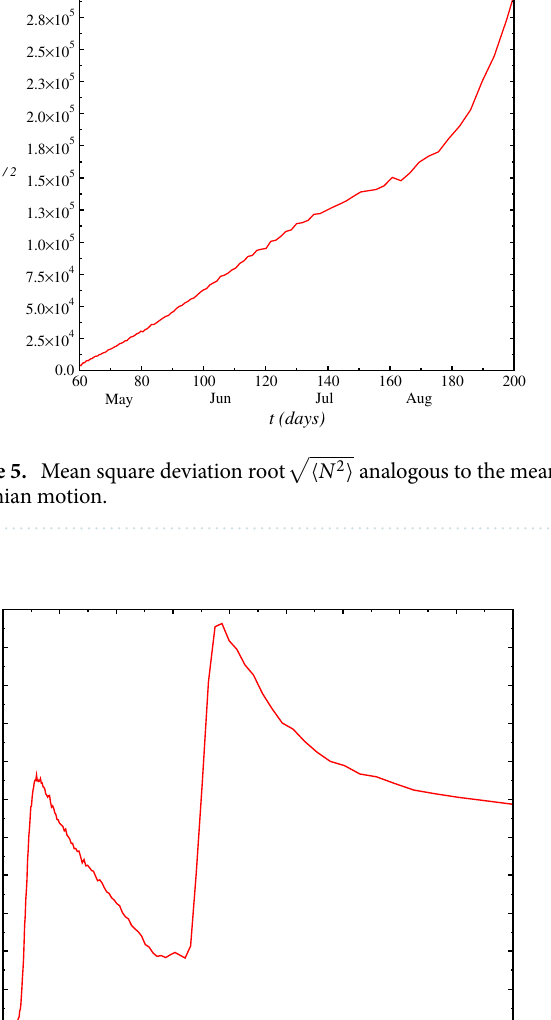
0 . The range of negative values obtained for the kurtosis indicates that the shape of the distribution is and g ( t ) ≡